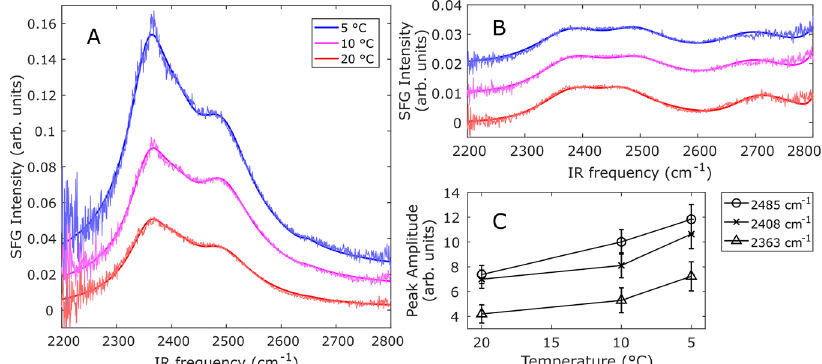
Fig. 2 Temperature-dependent OD-stretch SFG spectra collected in the ssp polarization combination, along with fi ts. For clarity, the 10 °C and 5 °C spectra are offset from the corresponding 20 °C spectrum by 0.01 and 0.02 arbitrary units, respectively. A Spectra of water molecules interacting with the ice-nucleating active protein InaZ9R in D 2 O-based PBS buffer. The intensity of the water signal is increased signi fi cantly for lower temperatures in the presence of inaZ9R. B Spectra of the neat buffer surfaces remain essentially unchanged. C Plot of the SFG amplitudes for the different water modes fi tted to the